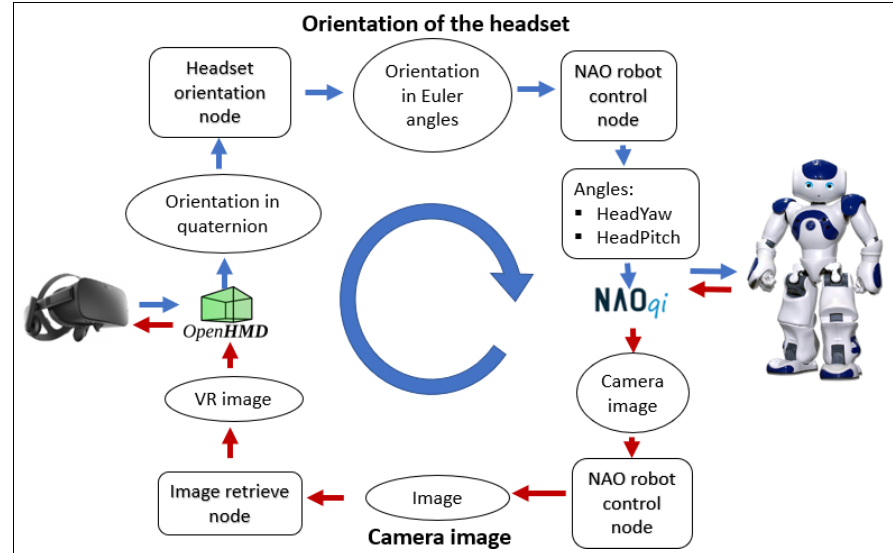
Figure 8. Software architecture of the data acquisition with the Meta